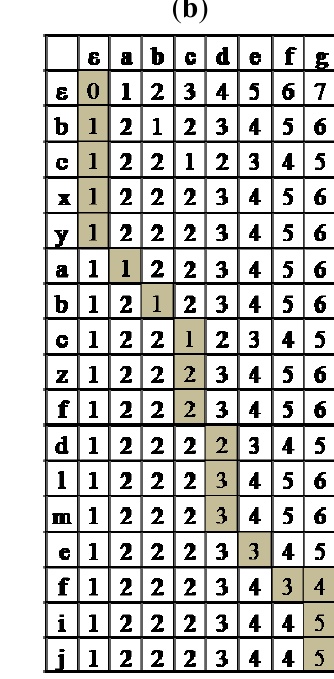
(corresponding to S  and T  ) is illustrated by gray colored cells. The number of block deletions is 4, and the deleted blocks are { bcxy,zf,lm,ij }. Figure 1. Edit distance Example: ( a ) with block deletion for S = bcxyabczfdlmefij and T = abcdef ; ( b ) with character insertions and block deletion for S = bcxyabczfdlmefij and T = abcdefg